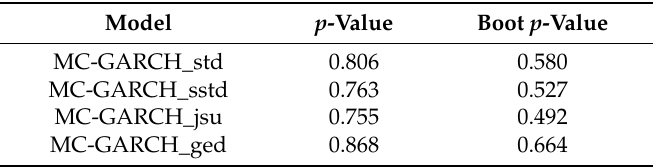
Table 8. Intraday ES forecast: bivariate ESR backtest results.